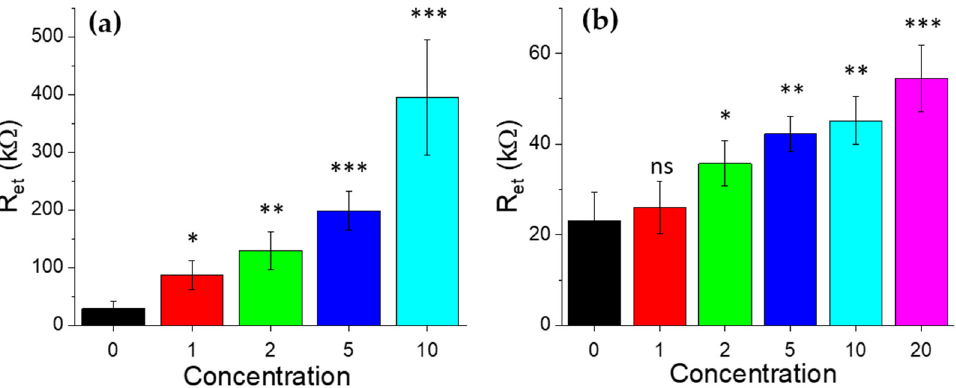
Figure 5. Statistical comparison among the LOC response at increasing ( a ) GLRaV-3 virus and ( b ) GFLVs virus concentrations (expressed as 100 divided dilution factor) with respect to the corresponding responses after antibody immobilization. p -values < 10% (*), p < 1% (**), p < 0.1% (***) were considered statistically significant. ns indicates no statistically significance.